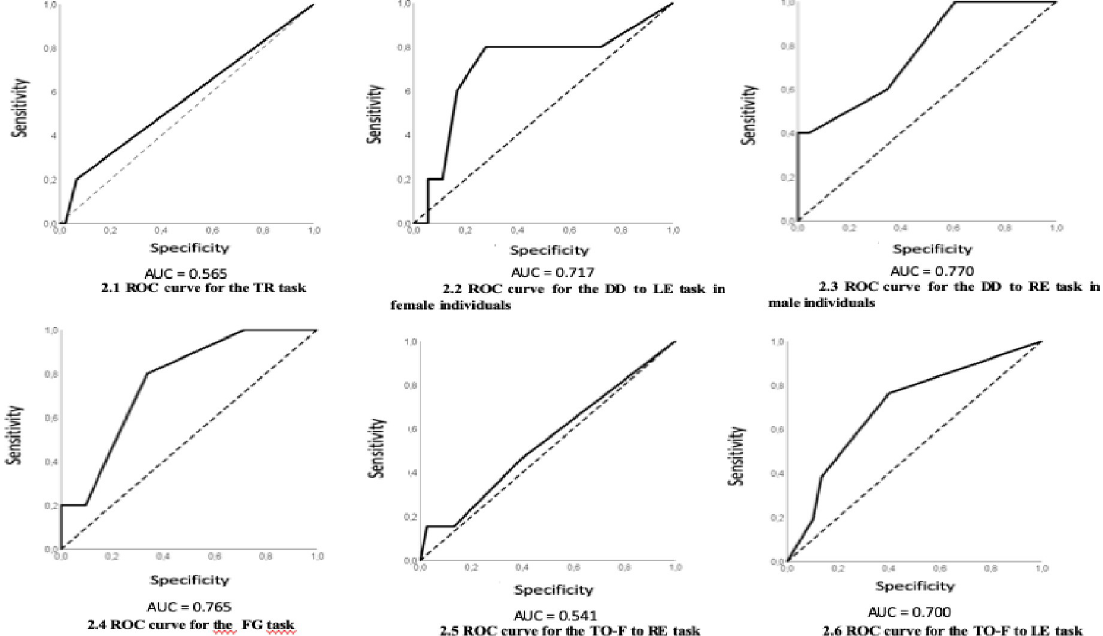
Fig 2. ROC curves for the auditory tasks of schoolchildren in the 8-year-old age group.